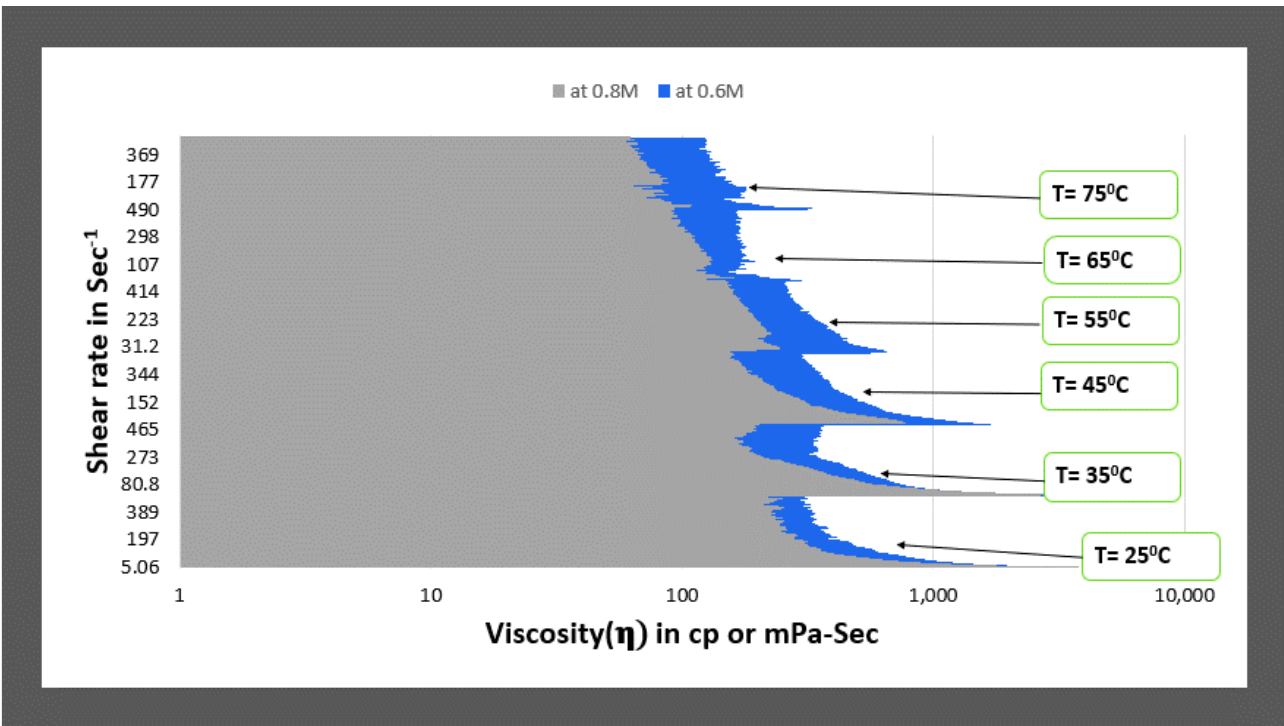
Figure 7. Viscosity curves for surfactant-based viscoelastic fluids of type2 with varying NaNO 3 concentrations at 25 °C. Please change the same as below.